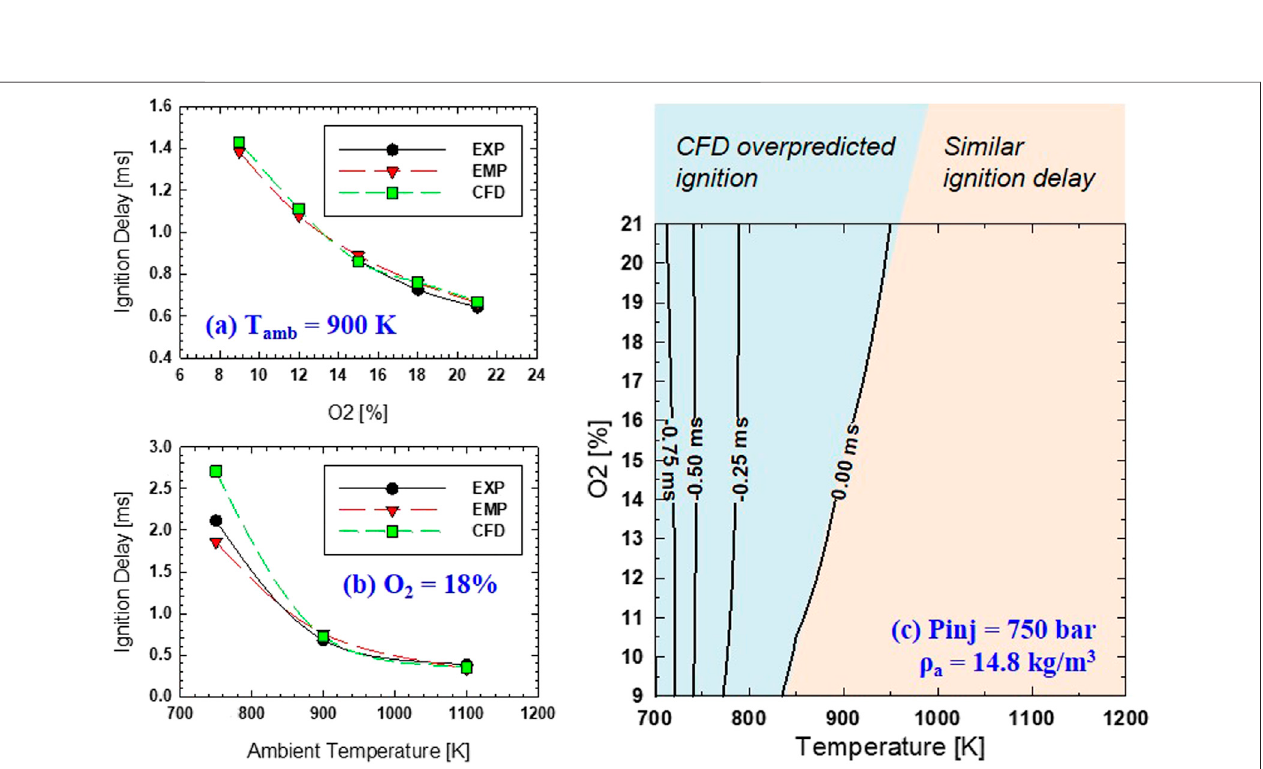
FIGURE4| IgnitiondelayoverdifferentT amb andO 2 predictedby: (A) homogeneousconstant-pressurereactor(grayscale)simulationat ϕ (cid:1) 1.65andP amb (cid:1) 3.77MPa;and spray experiment of 900K, 18% O 2 , 75 MPa, 14.8 kg/m 3 (blue solid lines); (B) CFD simulation (same condition as experiment) with ID de fi ned by CH 2 O pro fi le.